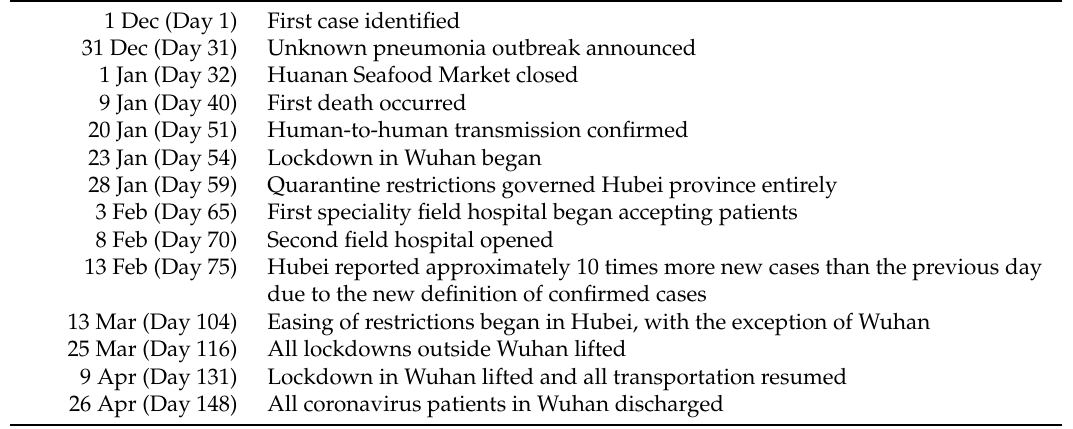
Table 2. Timeline of the COVID-19 pandemic in Hubei (December 2019–April